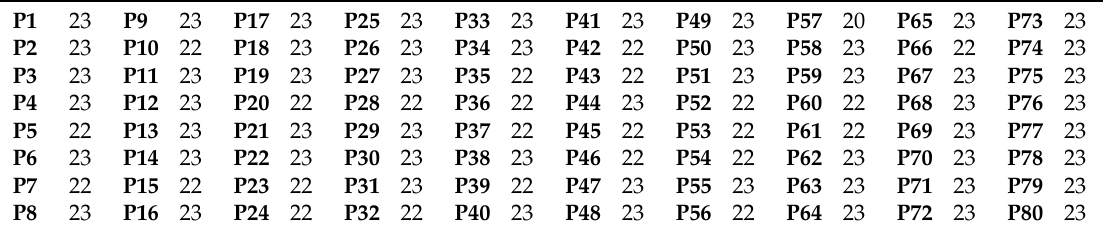
Table 5. Workloads of each personnel after scheduling is done with mathematical model.